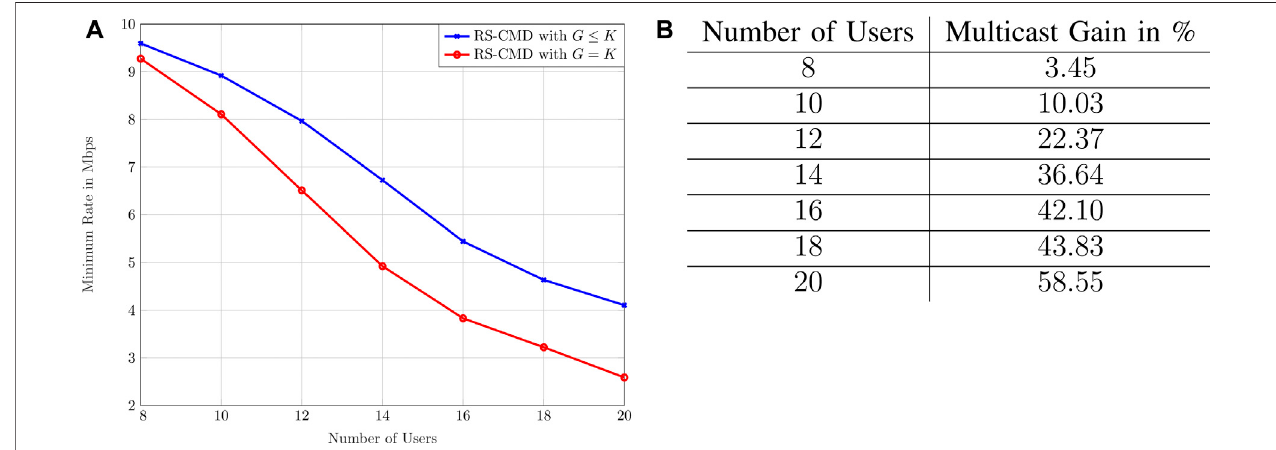
FIGURE6| MMFrateversusthenumberofusesforthestatisticalCSITcase.Weconsidertwodifferenttransmissionschemes,i.e.,RS-CMDwith G ≤ K and G (cid:3) K . (A) shows the MMF rate of RS-CMD with G ≤ K and G (cid:3) K as a function of the number of users. (B) is the MMF rate gain of RS-CMD with G ≤ K and G (cid:3) K in percent.